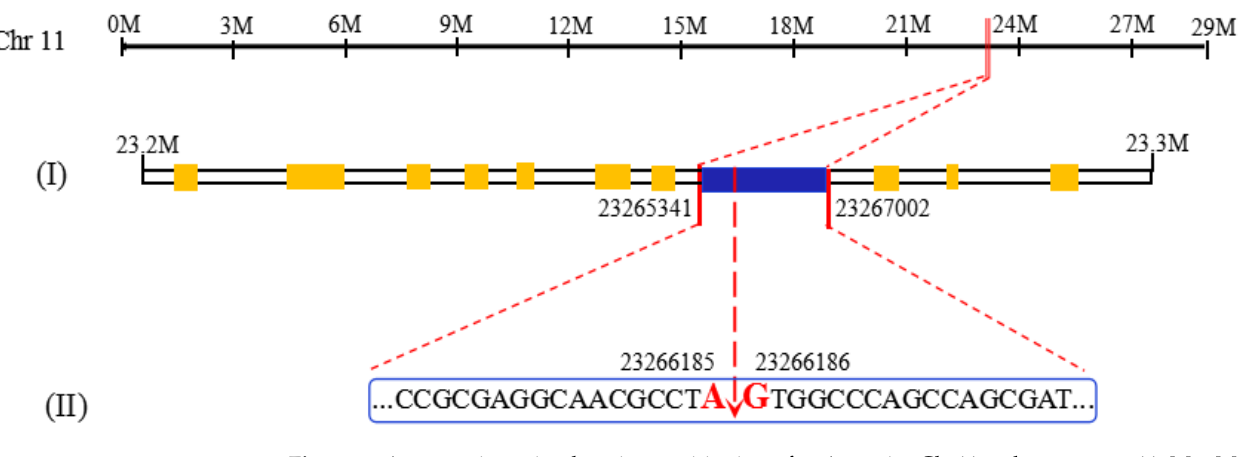
Figure 6. Accurate insertion location positioning of m-1a strain. Chr11 = chromosome 11; M = Mega base pair.